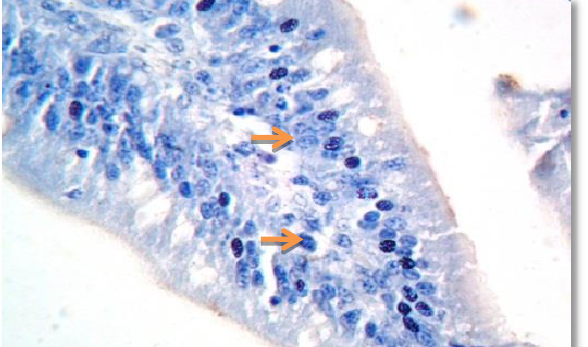
Figure,4: Macrophages in the duodenum of non heat stressed treated 14 days old chick G3. Macrophages in paraffin embedded sections (5µm) were identified by using an anti-chicken monocyte-macrophage mouse monoclonal antibody (KUL01) and an HRP – conjugated secondary antibody Immunopositive cells are purple-brown ( ) 100